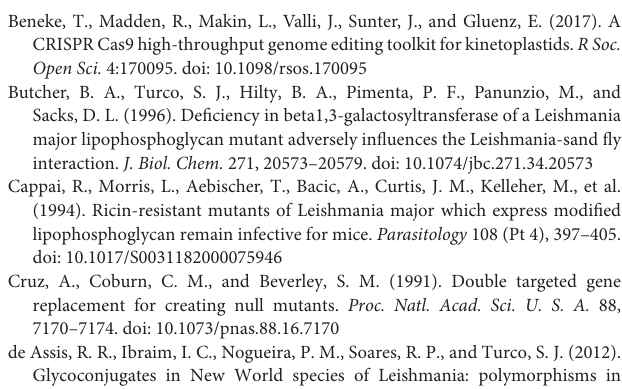
Supplementary Figure 1 | Detail of LPG2 gene locus indicating gRNA targeting sites. (A) Schematic representation of the wild-type alleles of the LPG2 gene (magenta box) present in a duplicated tandem array. (B) Schematic representation showing the insertion of a stop codon in LPG2 alleles following Cas9 genome editing (white line interrupting the magenta box). (C) LPG2 sequence depicting: gRNA440 sequence in (blue), oligonucleotide donor sequence (underlined) and inserted stop codons (red). Arrows represents primers used for LPG2 sequence and 1 lpg2 characterization. Supplementary Figure 2 | Characterization of 1 lpg2 clones. (A) Growth curve of wild-type (WT) L. infantum promastigotes and five different 1 lpg2 clones. (B) Analysis of growth curve of L. infantum wild-type (WT) promastigotes and mean growth rates of all five different 1 lpg2 clones (C) Area under the curve (AUC) of growth curve presented in (B) . (D) T7 Endonuclease I assay using genomic DNA from L. infantum wild-type (WT) promastigotes and two clones (E4 and G6) of L. infantum 1 lpg2 . A positive control containing equal amounts of WT and KO DNA demonstrates the presence of two bands following digestion. (E) Western blot analysis of L. infantum promastigotes (clone G6) demonstrating the loss of the pLdCN vector after 5–6 passages in the absence of the G418 marker. Supplementary Table 1 | Oligonucleotides sequences used to assemble the fragments pLPG2-Hyg and pLPG2-Neo for gene targeting of LPG2 by homologous recombination and